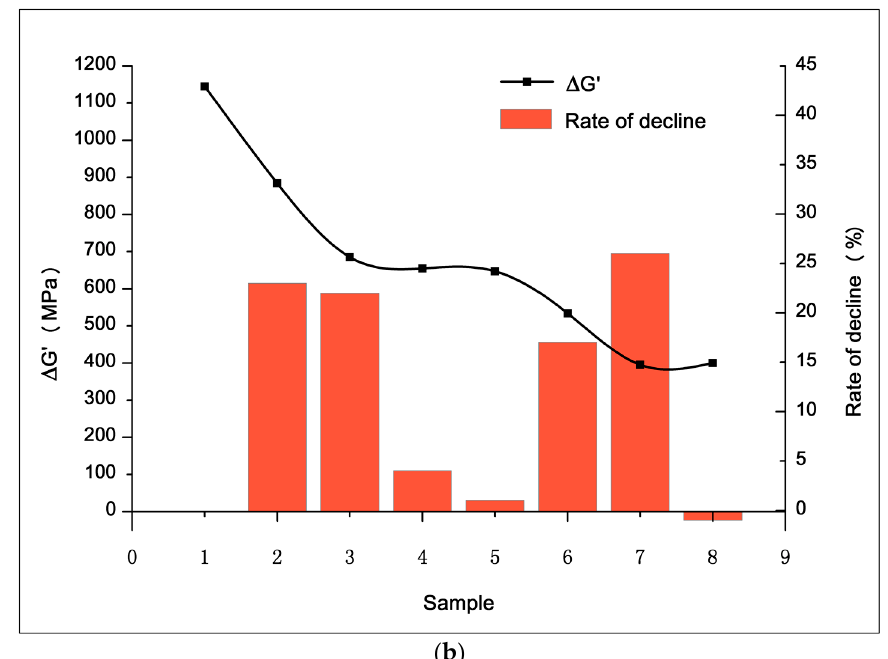
Figure 7. Result of Payne effect measurements. ( a ) The "G’-strain" curve of S1-S8, and ( b ) G’ difference and rate of decline of S1–S8.